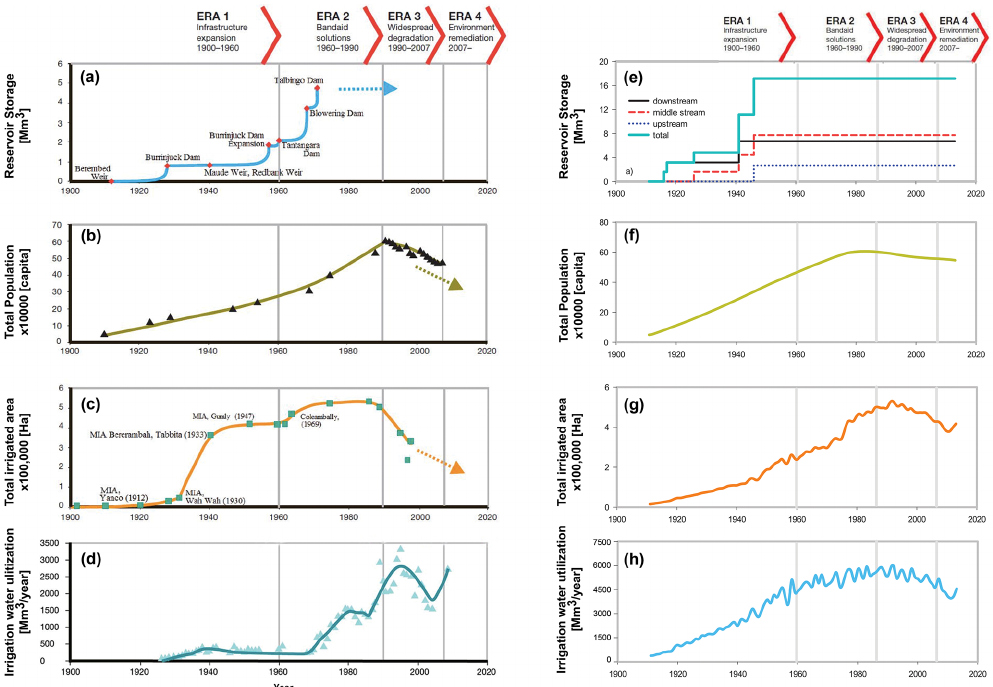
Figure 6. Observed (based on Kandasamy et al., 2014) and modeled pendulum swing in the Murrumbidgee basin during the study period (1910–2013). Observed times series of (a) reservoir storage, (b) total population within basin, (c) total irrigated area, and (d) irrigation water use. Modeled time series of (e) expansion of reservoir storage capacity, (f) total human population, (g) total irrigated area, and (h) irrigated water